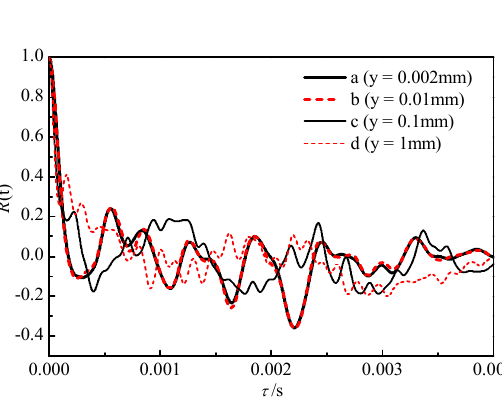
Figure 16. Streamwise velocity autocorrelation at monitoring points. ( 𝑈 = 2 m s⁄ , 𝑥 = 30 mm, 𝑧 = 5 mm ). (cid:3029)